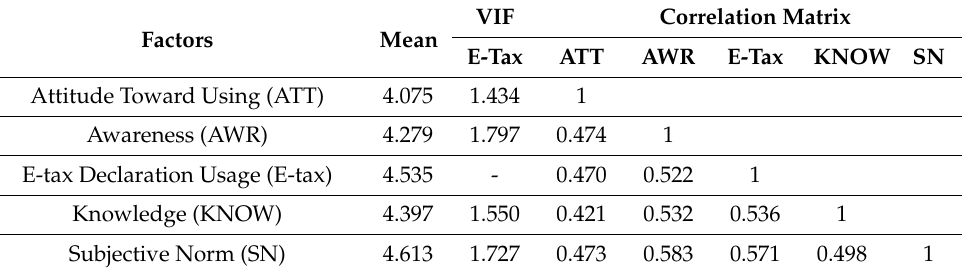
Table 4. Correlation Matrix and Collinearity statistics